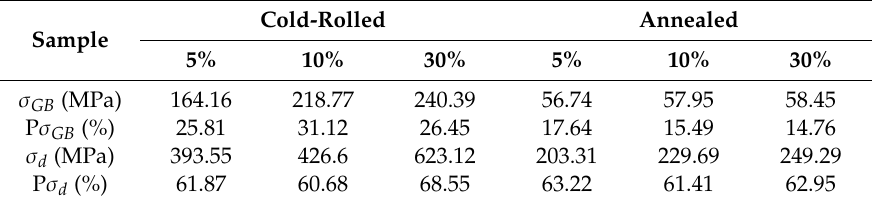
Table 5. Contributions of grain boundaries and dislocation on strength. P σ GB and P σ d represent the proportion of grain boundary and dislocation strengthening in yield strength,